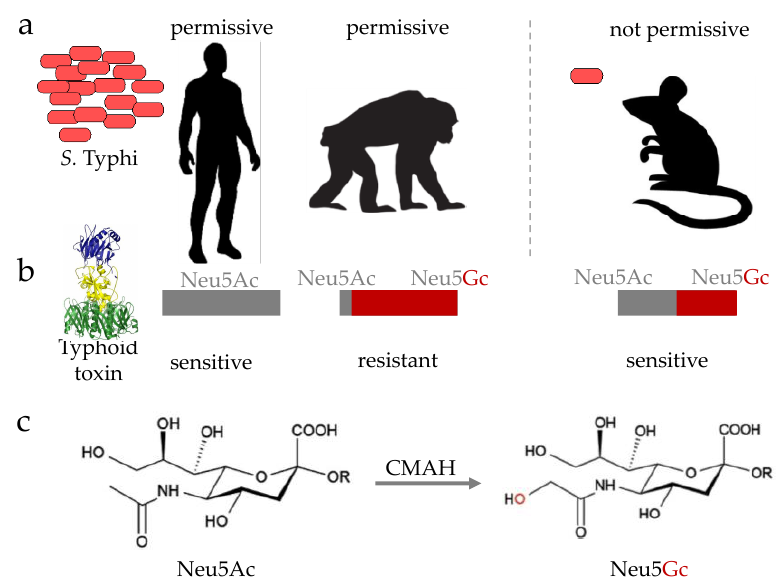
Figure 2. Cartoons depicting S. Typhi permissiveness of human and animal models ( a ), the expression of typhoid toxin’s glycan receptor ( b ). Chemical structures of Neu5Ac and Neu5Gc are shown in ( c ). cytidine monophosphate- N -acetylneuraminic acid hydroxylase (CMAH) converts Neu5Ac to Neu5Gc. NOD/SCID/ γ C null (NSG) humanized mice infected with S. Typhi strain Ty2 have been shown